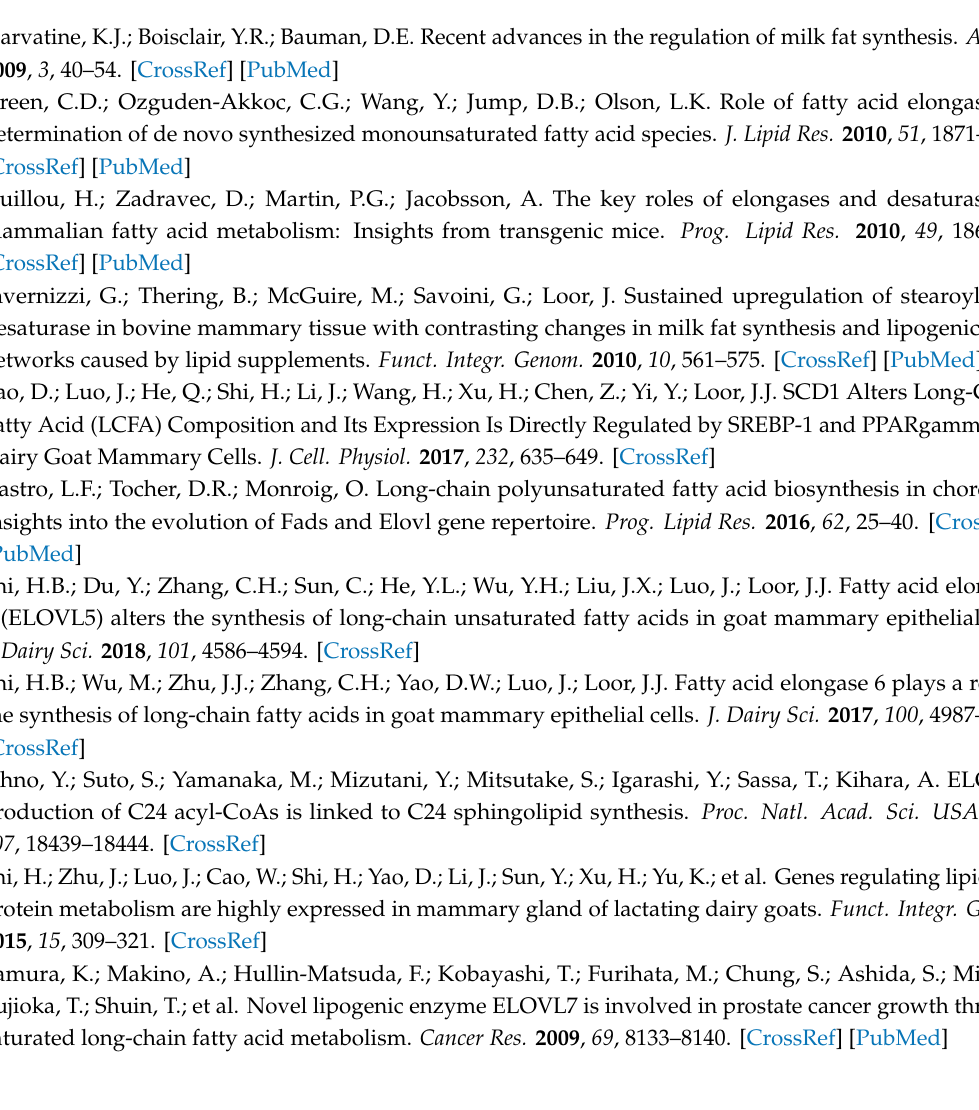
Table S1: Special oligonucleotide sequence of siRNA for ELOVL7. Table S2: Name, accession number, sequences, amplicon length of primer pairs used in the present experiment, e ffi ciency of amplification of PCR, and references. Figure S1: Cellular TAG assays after altering ELOVL7